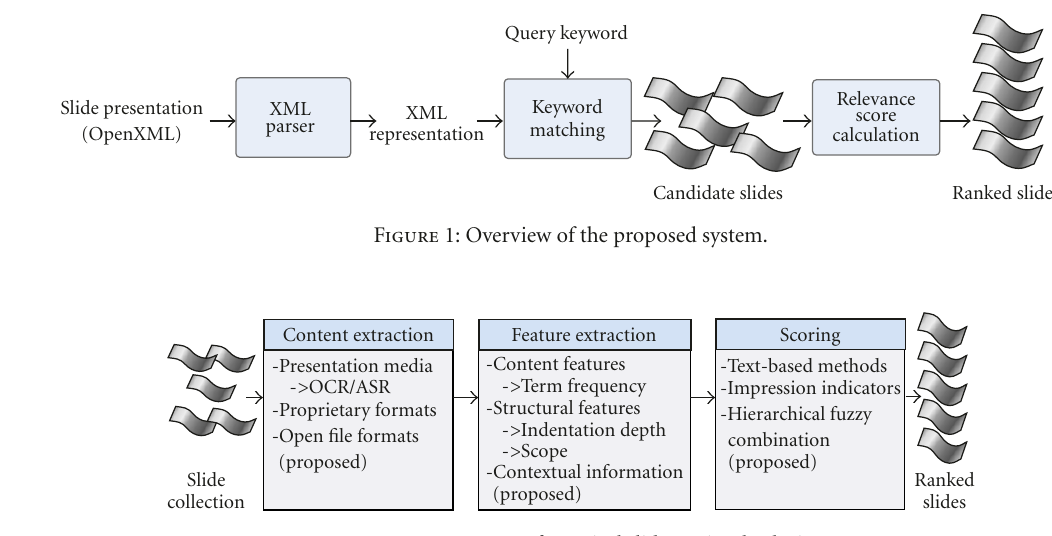
Figure 2: Components of a typical slide retrieval